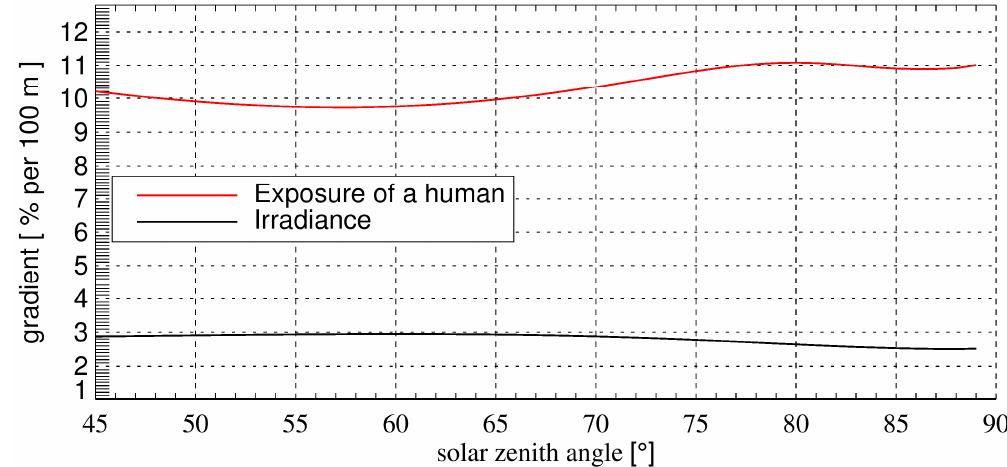
Figure 3. Gradients of valley (albedo = 0.02) to mountain (albedo = 0.6) values as increase with altitude in % per 100 m in dependence of the SZA. The gradients were calculated with Equation (4).